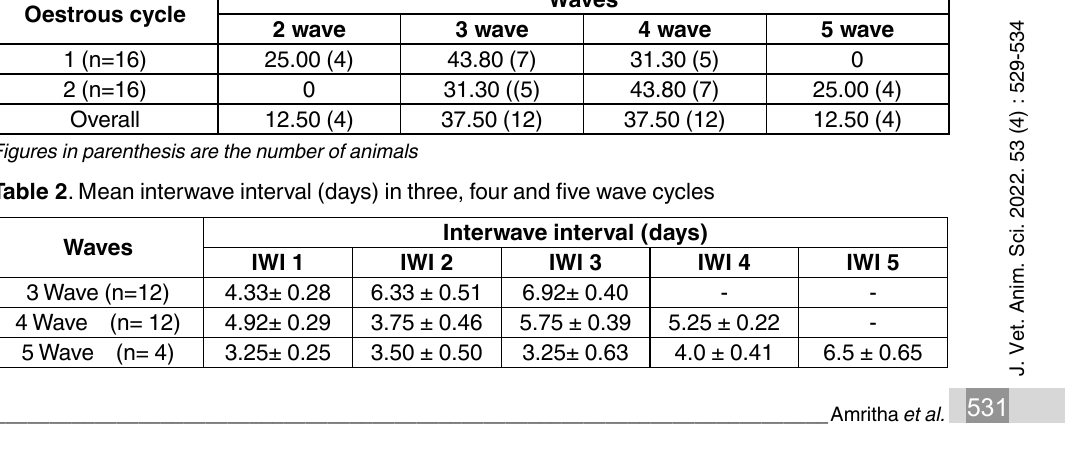
table 1 . Number of follicular waves per oestrous cycle (per cent ) Oestrous cycle